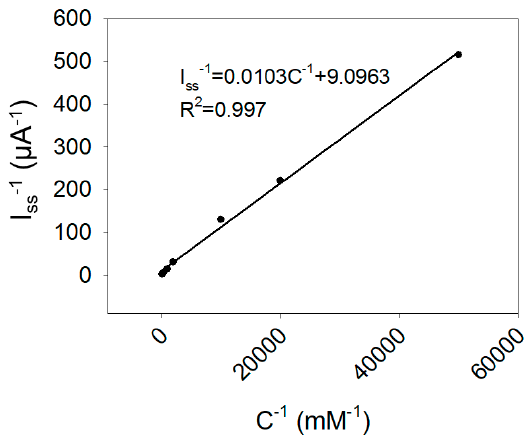
Figure 6. Lineweaver–Burk plots of the BCNPs/Tyr/Nafion/GCE electrode.